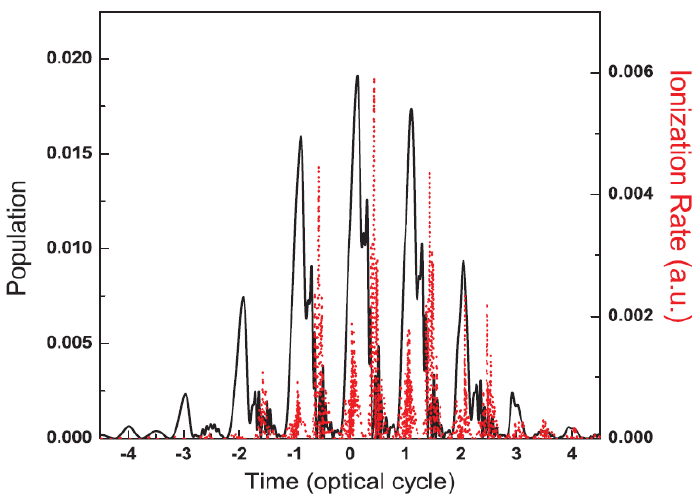
Figure 4. Population of the first excited state 2 p  (solid black line) and the total ionization rate (dotted red line) as a function of time. The laser parameters are the same as those in Figure